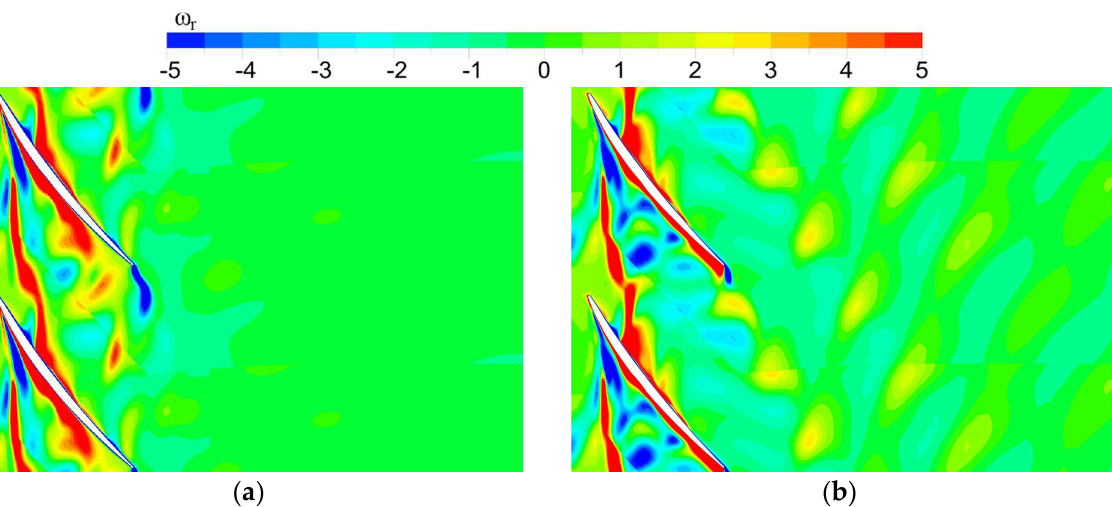
( b ) Figure 24. Distribution of root mean square of normalized axial velocity disturbance at 99% span. ( a ) Re = 1 × 10 5 ; ( b ) Re = 4 × 10 5 . 4. Conclusions The effect of an unsteady wake on the downstream flow field in a high-pressure com- pressor has been investigated in detail. The differences in the flow field with and without the wake were obtained by comparing the steady and unsteady calculation results. In ad- dition, the influence of the Reynolds number on the wake unsteadiness was considered. The main conclusions can be summarized as follows. The wake was observed to have a beneficial effect on the efficiency of the rotor at a high Reynolds number, but this effect weakened and became negative with decreasing the Reynolds number. The blockage region of the rotor outlet was divided into three parts: tip region, mainflow region, and hub endwall region. The flow blockage in the tip region was found to be mainly caused by the tip clearance vortex, which is the dominant factor in the loss over the whole flow field. The wake produced a different effect on the flow blockage in the tip region at different Reynolds numbers, consistent with the trend in ef- ficiency. Compared with the static entropy of the outlet without the wake, the presence of the wake increased the entropy at the top of the mainflow region. As the Reynolds number decreased from 4 × 10 5 to 1 × 10 5 , the magnitude and range of the entropy reduction region behind the blade pressure surface increased. Due to the influence of the wake on the blade